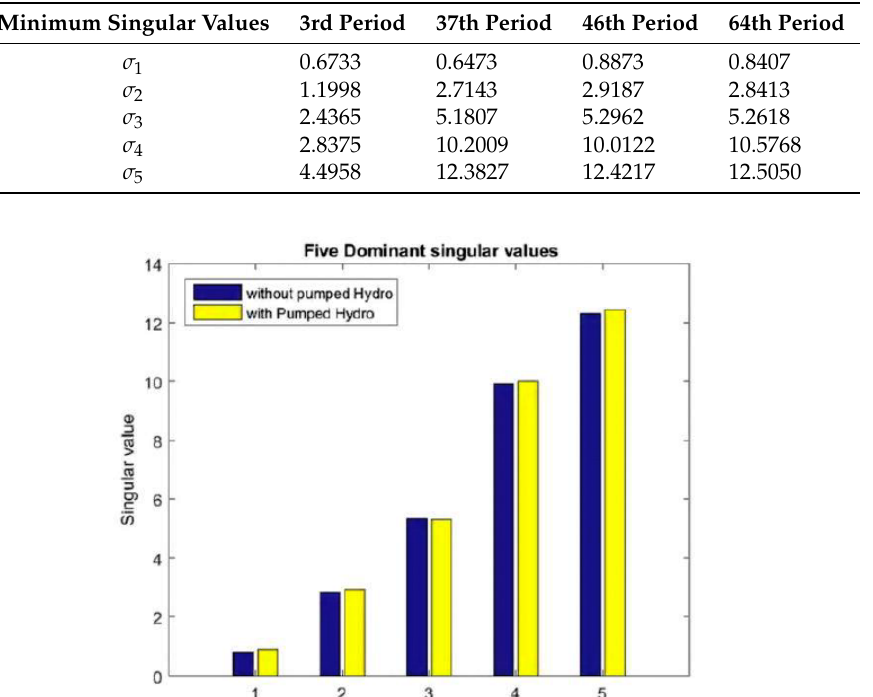
Table 6. First 5 MSVs for all four periods of wind curtailment on the 3rd, 37th, 46th, and 64th periods: